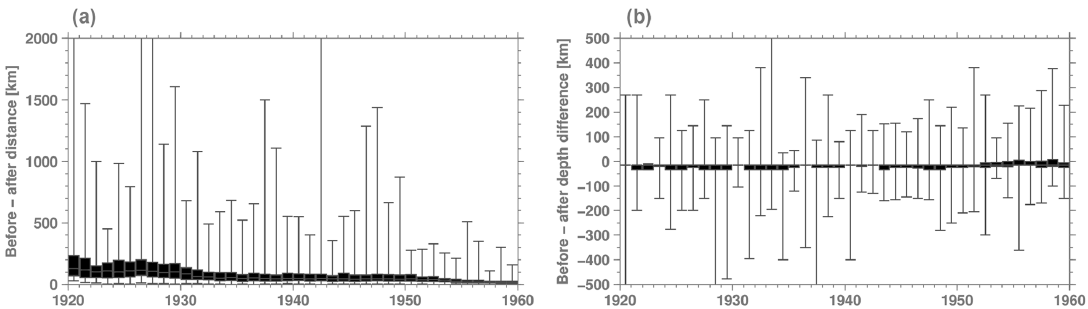
Figure 8. Box-and-whisker plots of the epicentre (a) and depth (b) differences between previous hypocentres (before) from ISS (or authors adopted by ISS) and ISC-GEM (after) locations in each year. For 9417 of the 11572 extension events relocated between 1920 and 1959 the depth for the previous hypocentres (before) was unknown and nominally set to